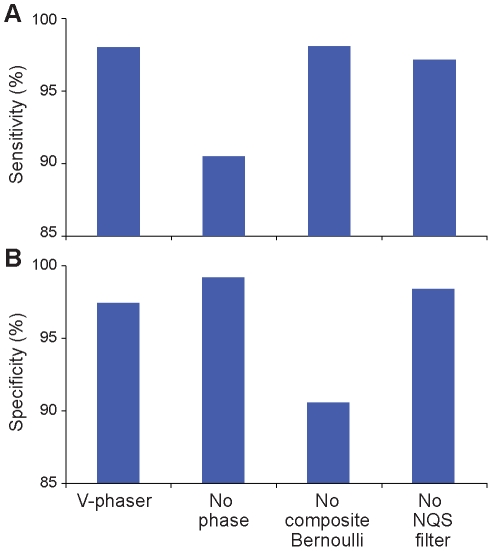
Phase information increased sensitivity, and base quality scores increased specificity.We compared V-Phaser to alternate versions of V-Phaser with specific components disabled. In the No Phase version, V-Phaser called variants without phase information. In the Uniform Errors version, V-Phaser estimated uniform error rates within homopolymer and nonhomopolymer regions without regard to assigned base qualities. In the No Filtering version, V-Phaser did not filter out low quality bases. (A) Phase information increased sensitivity. The version without phase information attained a sensitivity of 90%, but all other versions of V-Phaser used phase information and attained a sensitivity of 97% or more. We calculated sensitivity as the percentage of known variants correctly identified. Data are from WNV mixed population control dataset. (B) Individual base quality scores increased specificity. Among loci with mismatches, the Uniform Errors version had only 91% specificity, but all other versions incorporated base quality scores in their probability model and attained 97% specificity or more. We calculated specificity as the percentage of loci in the control sample correctly identified as having no variants among loci that had at least one candidate variant. Data are from infectious clone (HIV NL4-3) control dataset.